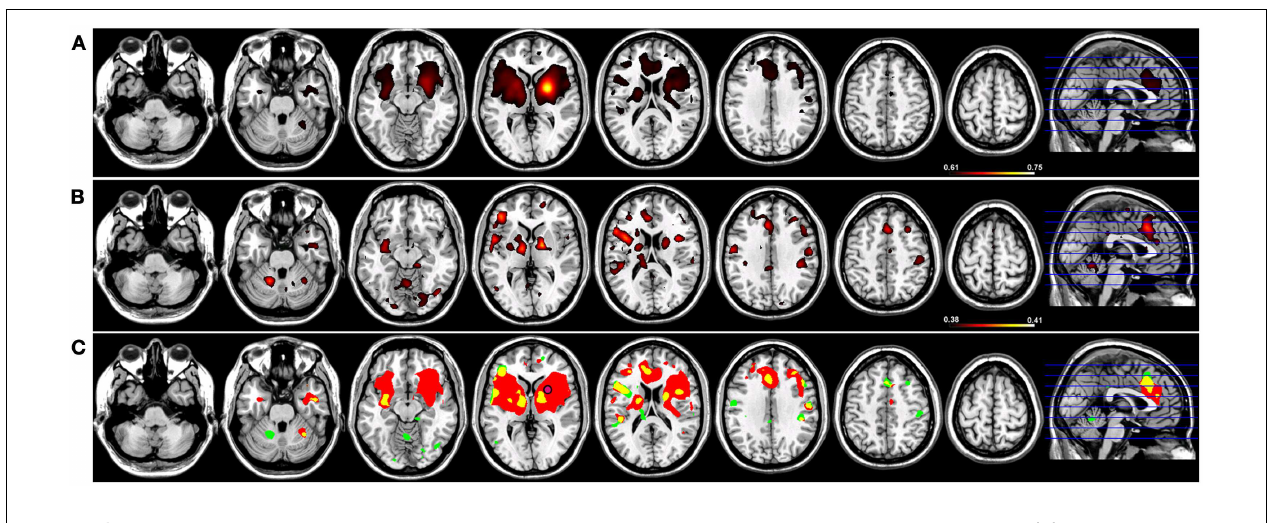
FIGURE 5 | Resting-state functional connectivity maps for a seed placed in the right putamen (pink circle) in 15 healthy control subjects reconstructing the right basal ganglia network (BGN) . (A) BGN reconstruction using magnitude coherence (Coh). (B) BGN